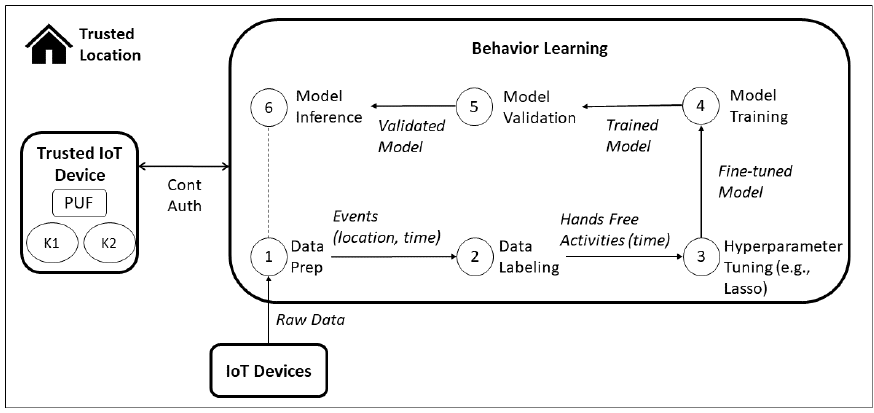
Figure 12. Hands-free activity detection proof of